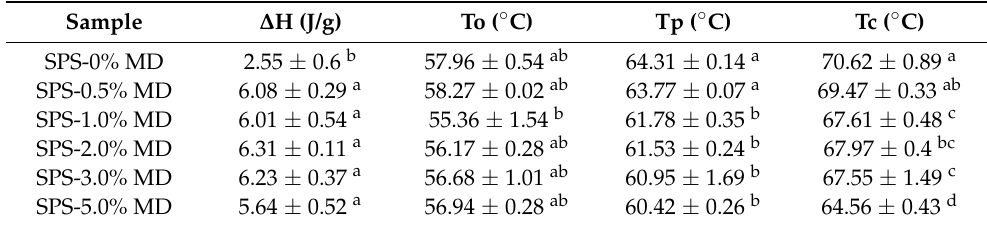
Table 3. Gelatinization parameters of sweet potato starch (SPS) noodles with various (0, 0.5, 1, 2, 3, and 5%, w/w) maltodextrin (MD)